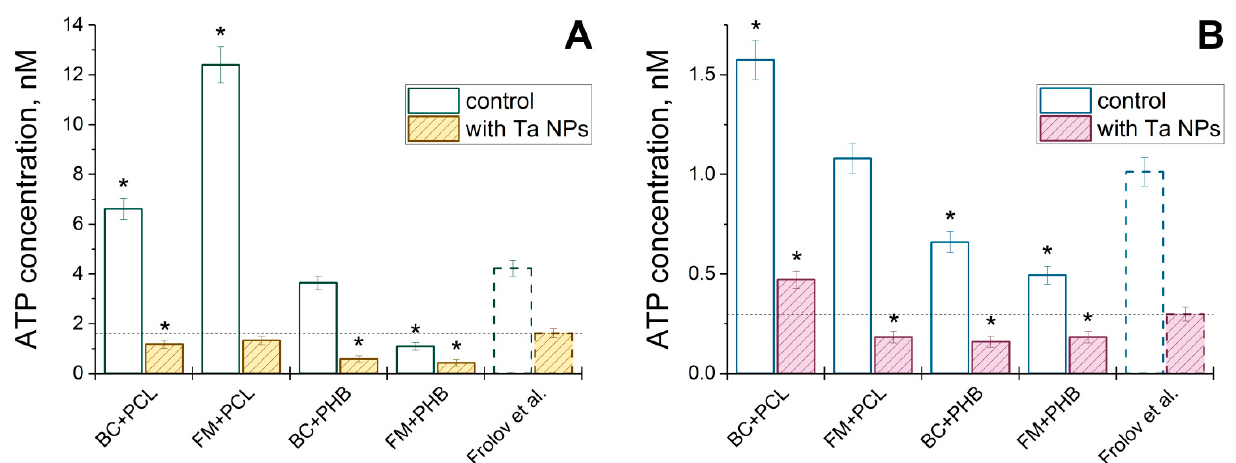
Figure 3. Antibacterial activity of composite fiber materials modified with PCL or PHB and func- tionalized with or without Ta NPs toward E. coli ( A ) and Bacillus subtilis ( B ) bacterial cells. It was estimated via analysis of residual intracellular ATP concentration in bacteria exposed onto composites for 24 h. Previously investigated fiber material [27] (labeled as “Frolov et al.”) was issued under the same conditions, and samples with statistically significant differences compared to ref- erence material (one-way ANOVA with Holm-Sidak multiple comparison test, p < 0.05) were marked with an asterisk.